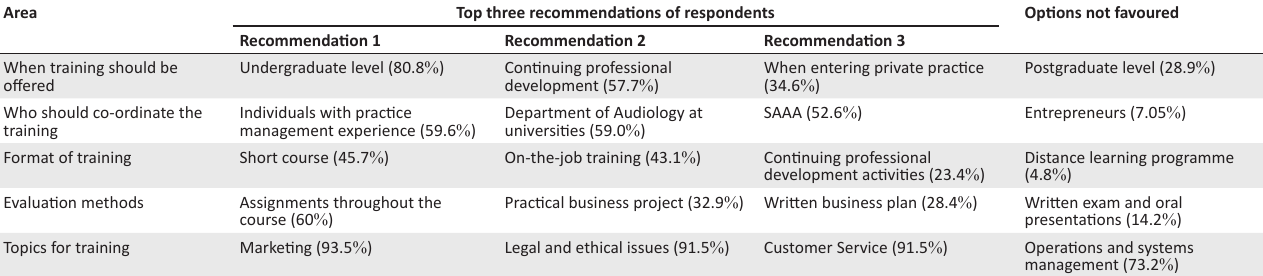
TABLE 6: Summary of training recommendations ( n =